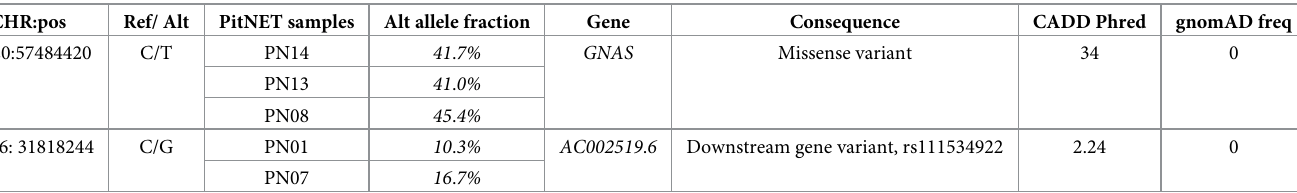
Table 2. Somatic variants detected in more than one PitNET